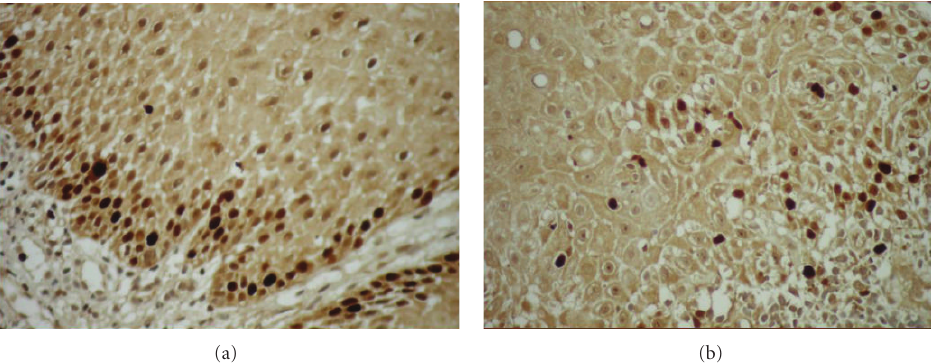
Figure 6: (a) Ki-67 expressions in the squamous epithelium (Ki-67 × 40). (b) MCM-2 expression in the squamous epithelium (MCM-2 × 40).